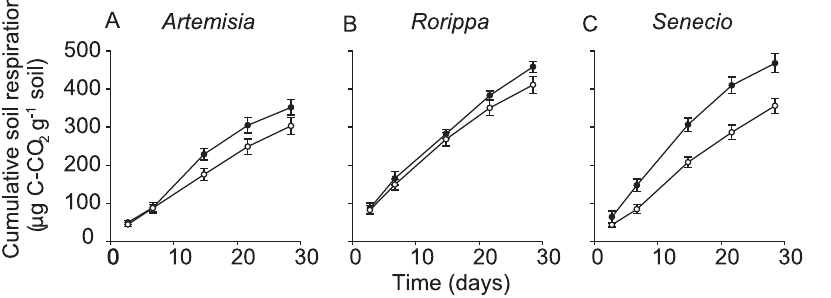
Figure 1. Mean cumulative soil respiration. ( 6 SE). Measured in flasks with litter from exotic (filled circles) and native plant species (open circles) for Artemisia (a), Rorippa (b), and Senecio (c).